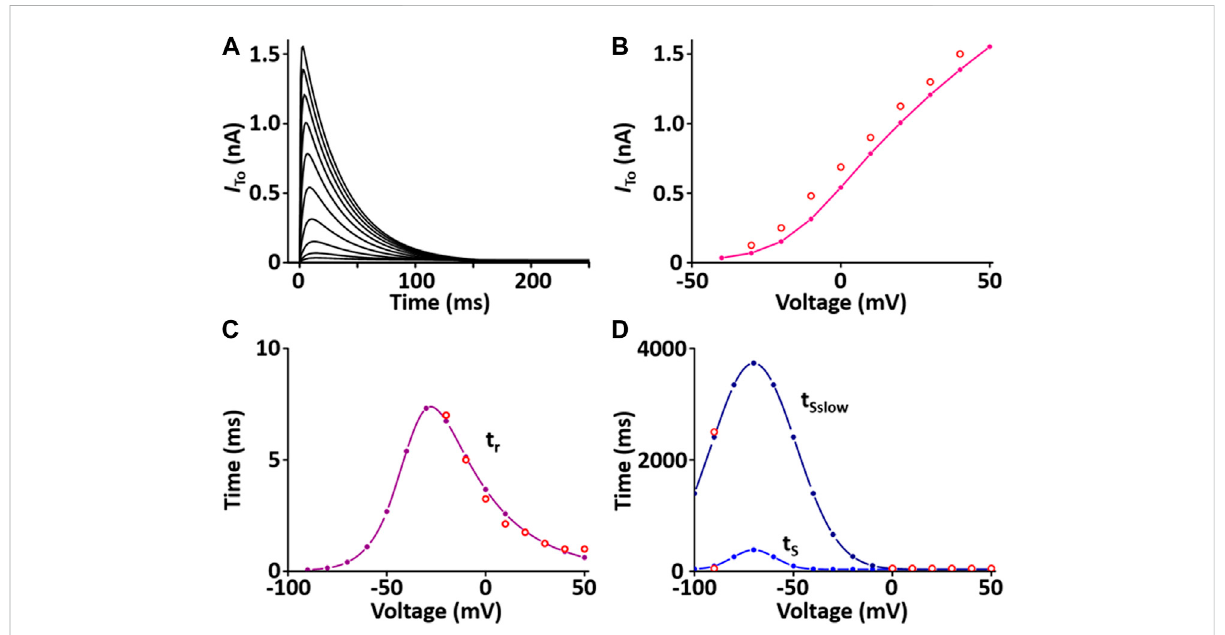
FIGURE 2 Veri fi cationof I to implementation(Kim,2018). (A) SimulatedcurrenttracesofCa 2+ -independenttransientoutwardK + channel. (B) Simulated I-V relationship for I to (pink line). This simulated result is in close agreement with representative experimental result (o, Clark et al., 1995). (C) Simulated activation time constant ( τ r , purple line). This simulated result is in close agreement with the representative experimental result (o, Agus et al., 1991). (D) Simulated inactivation time constants ( τ S, τ Sslow , blue lines). This simulated result is in close agreement with the representative experimental result (o, Wettwer et al.,